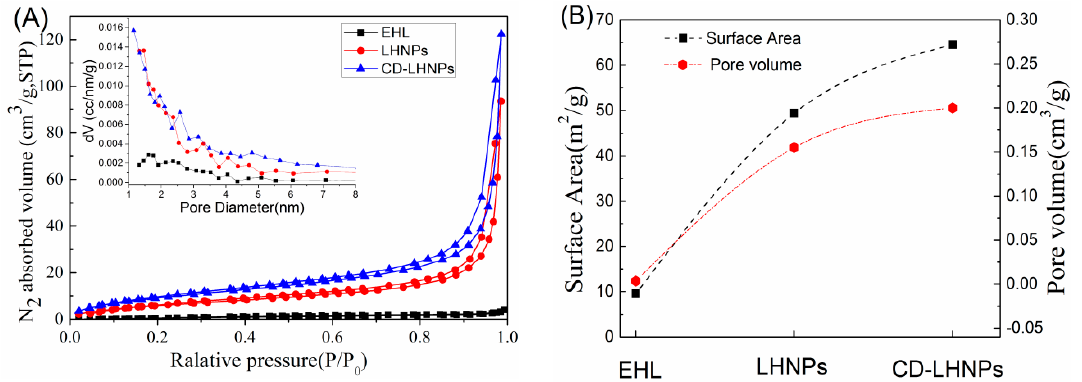
Figure 5. ( A ) Nitrogen sorption isotherms of EHL, LHNPs and CD-LHNPs; ( B ) surface area and pore volume.